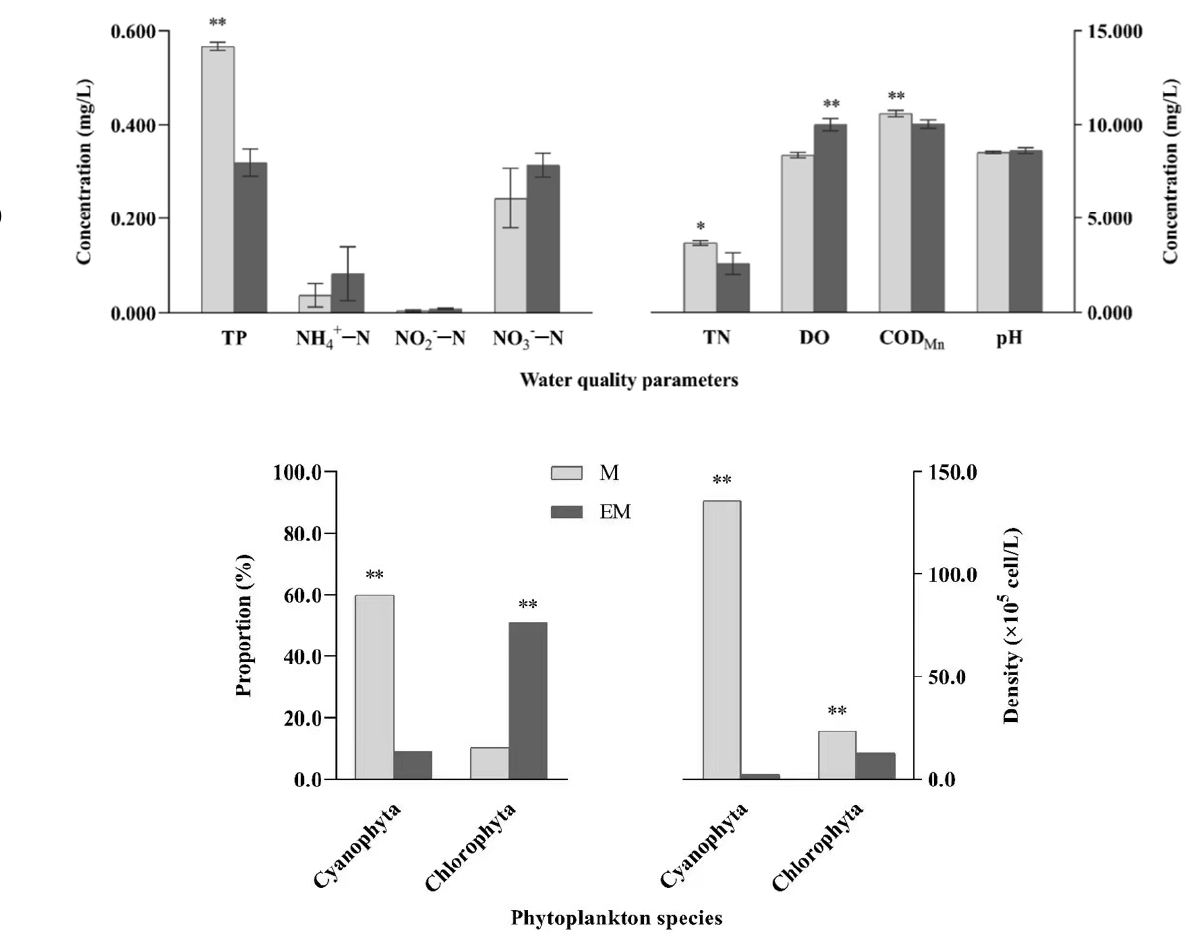
Figure 2. ( A ) Water quality parameters and ( B ) dominant phytoplankton (Cyanophyta and Chloro- phyta) in the M and EM group. Note: p < 0.05 indicated significant (*), p < 0.01 indicated highly significant (**).